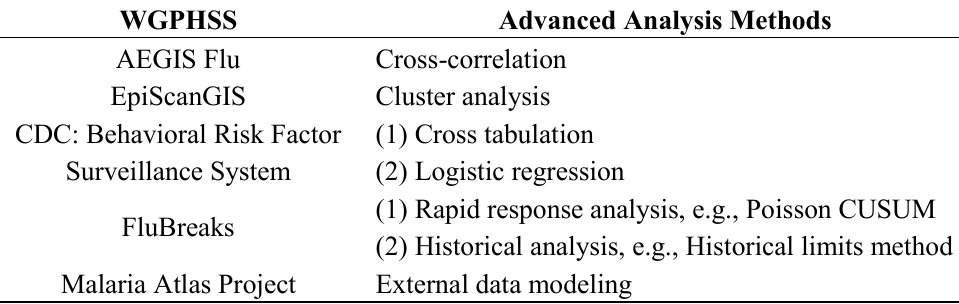
Table 5. Advanced analysis supported in corresponding